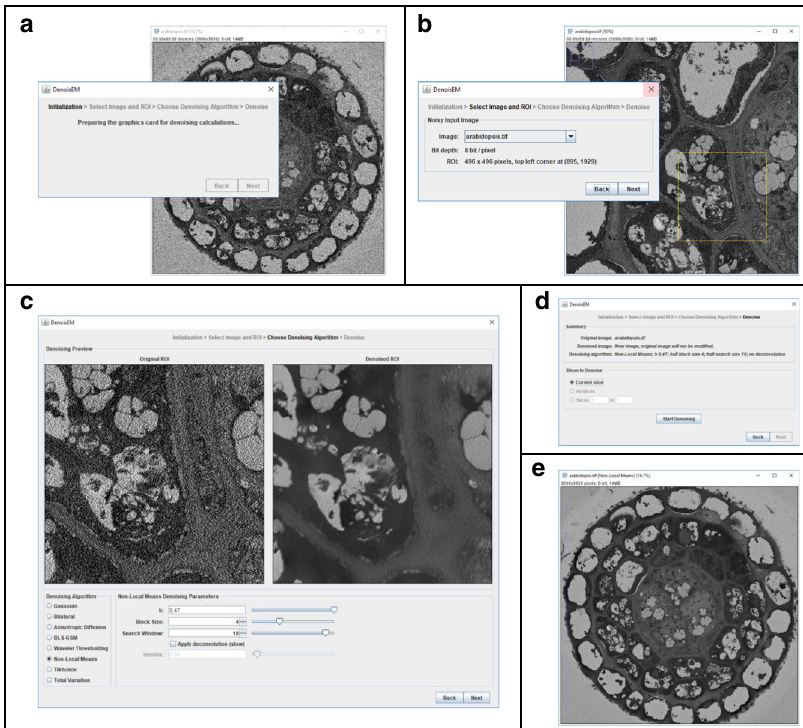
Fig. 2 An overview of the user interface (UI) of the DenoisEM plugin for ImageJ. It is structured as a wizard that guides the user through the denoising process in a sequence of steps. a In ImageJ, the user loads an image or image stack for denoising and starts the DenoisEM plugin. The UI wizard appears, and the computational backend for parallel processing on the CPU/GPU (Quasar) is initialized. b In the next step, the user chooses any of the open images for denoising and selects a ROI on which denoising will be previewed. c Next, the main panel in the plugin appears. At the top it shows side-by-side the noisy original as well as the denoised version of the selected ROI. In the bottom left corner, the user can select one of eight denoising algorithms. The bottom right has controls for specifying the algorithm parameters. Typically, if the algorithm or its parameters are changed, the denoised ROI at the top is updated virtually instantaneously. This allows the user to easily assess the effect of algorithms and parameter settings. d After optimal settings are chosen, the user is shown a short summary and (for image stacks) can select the image slices that need to be denoised. During denoising, the user is shown progress feedback. e When denoising is fi nished, a new image or image stack is created and displayed. The original image (stack) is left